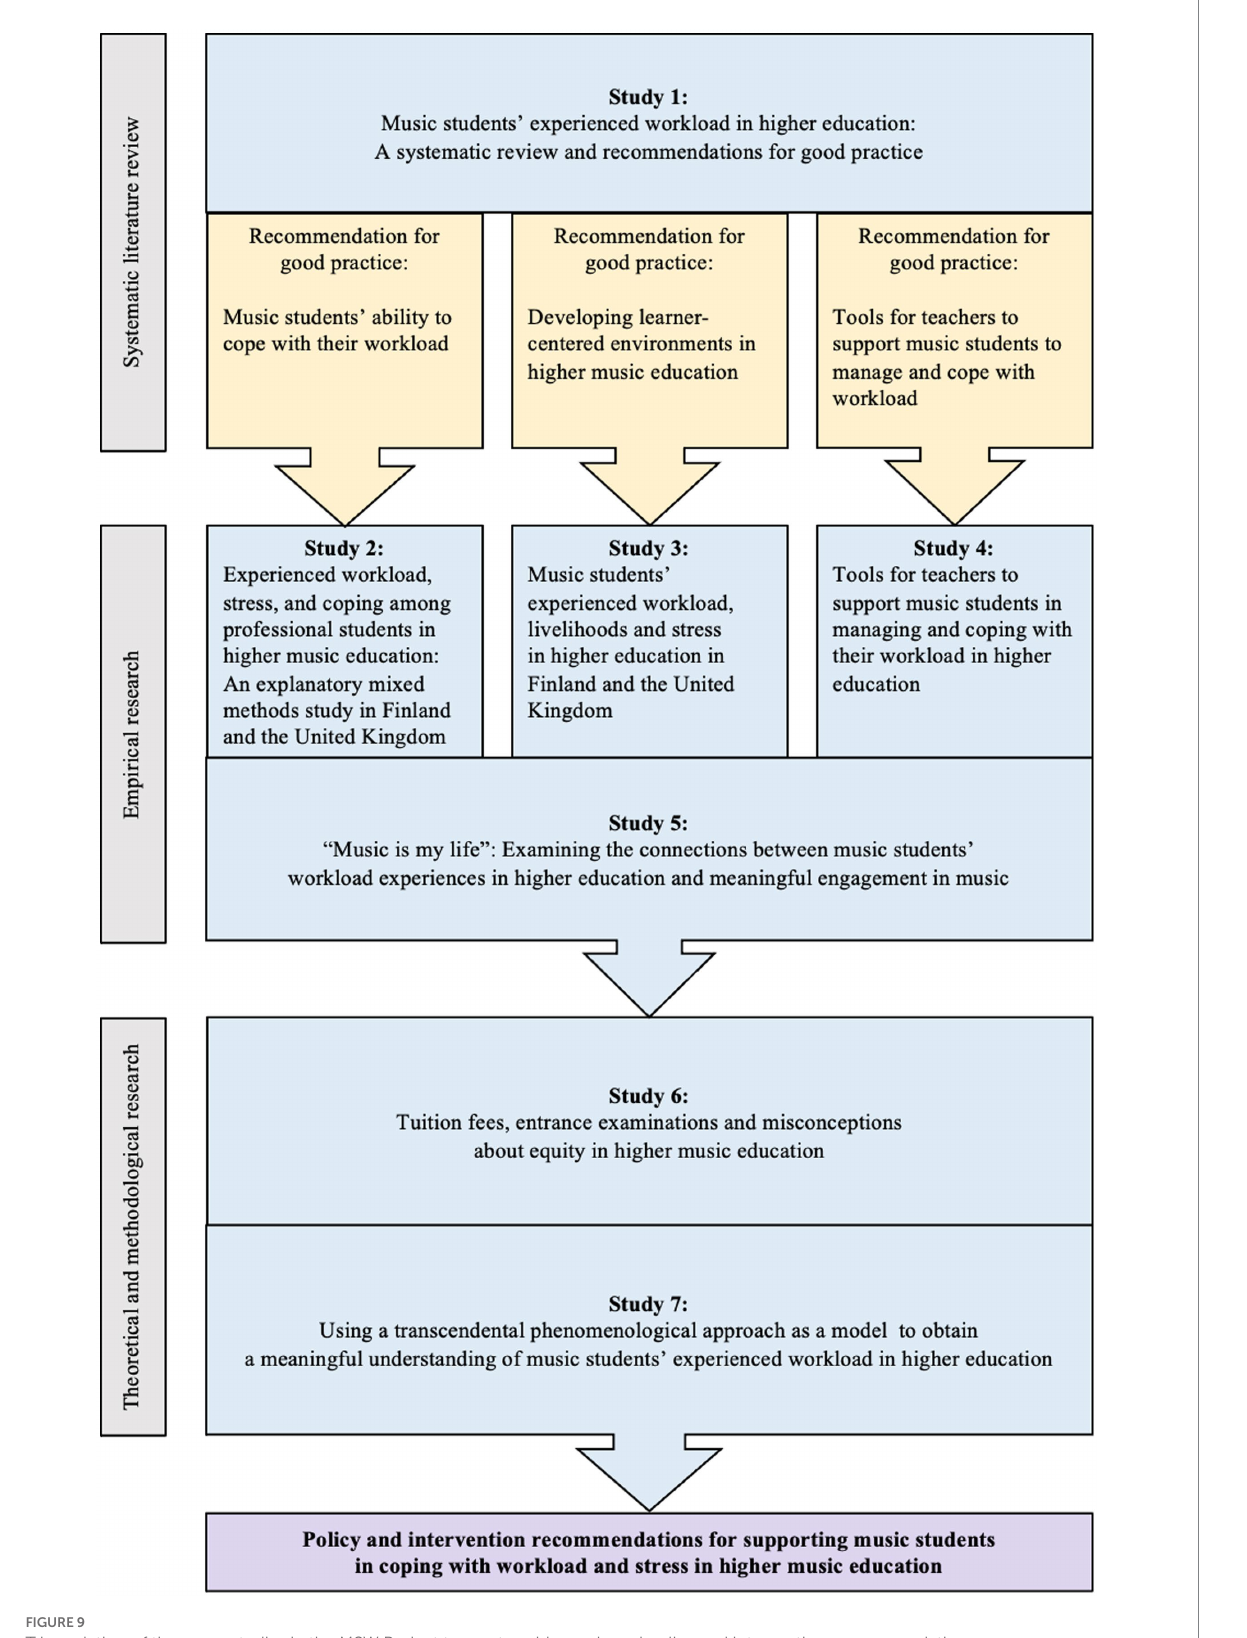
FIGURE 9 Triangulation of the seven studies in the MSW Project to create evidence-based policy and intervention